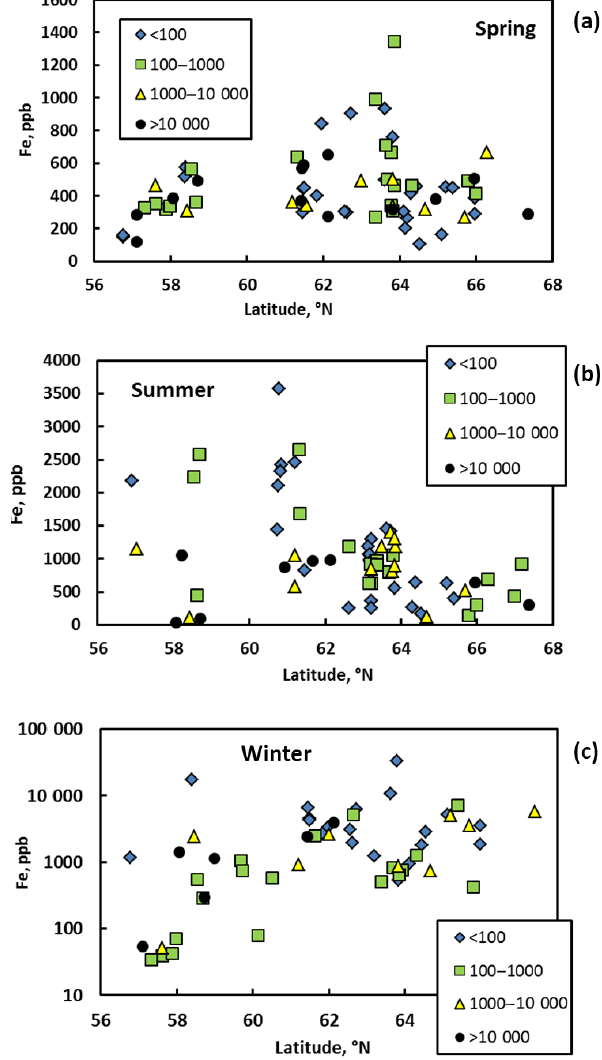
Figure 2. Variation in river water dissolved Fe with the increase in latitude during spring (a) , summer (b) and winter (c) . The variability among different watershed size is smaller than that between the sea- sons and within the latitude gradient. Diamonds, squares, triangles and circles represent watershed of size <100km 2 , 100 to 1000km 2 , 1000 to 10000km 2 , and >10000km 2 ,